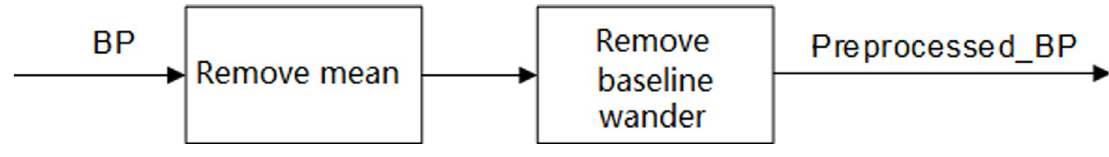
Fig 8. BP preprocessing procedure